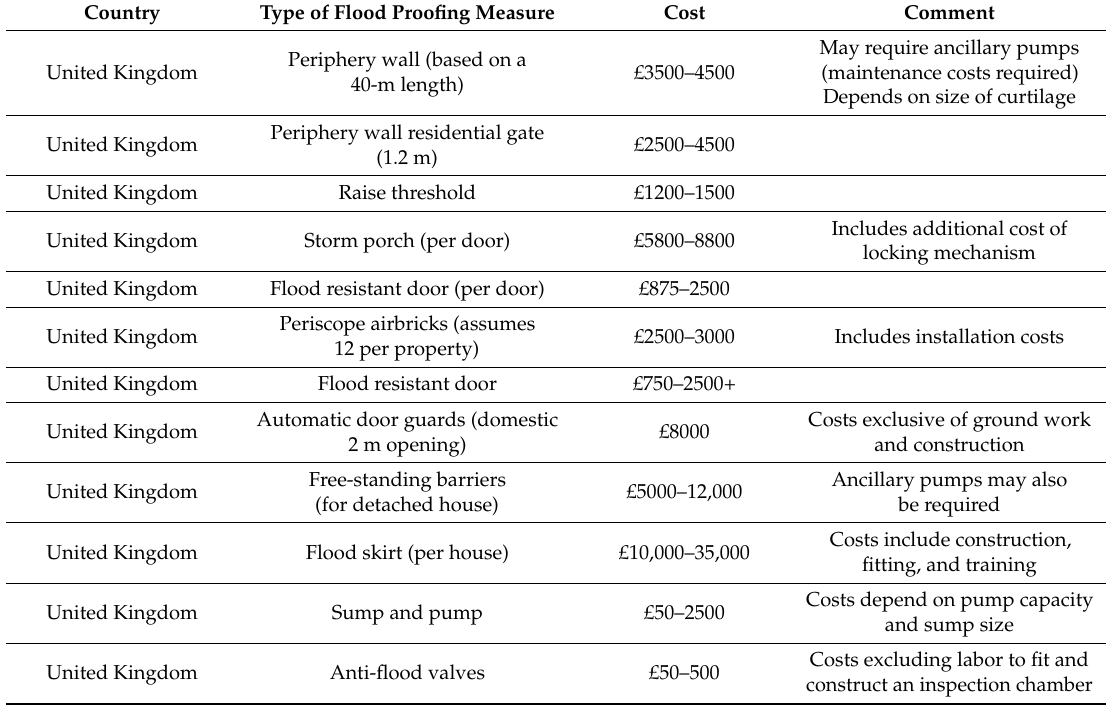
Table A3. Individual flood-proofing measures (Env. Agency [111]).